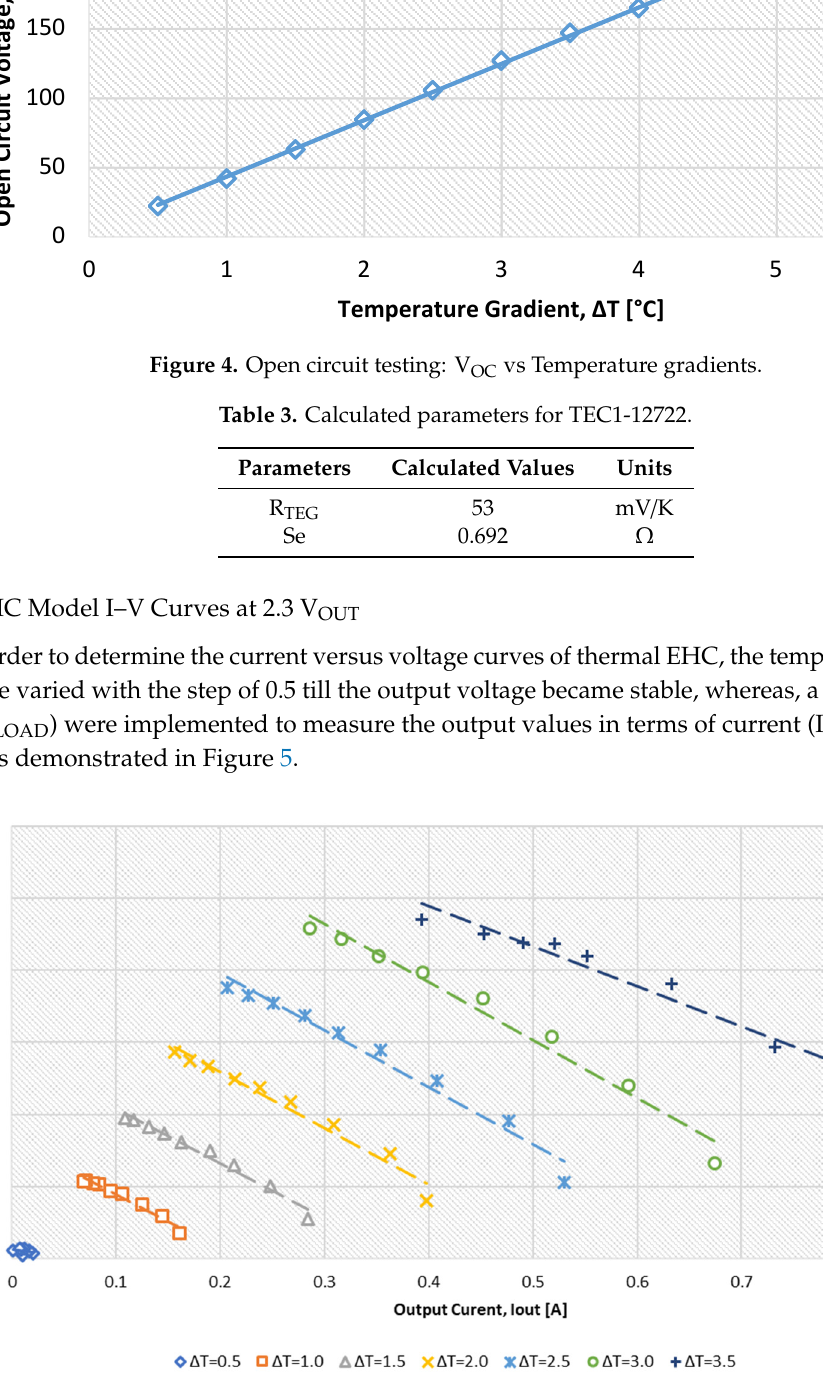
Figure 5. Thermal EHC Output Voltage–Output Current curve at 2.3 V.